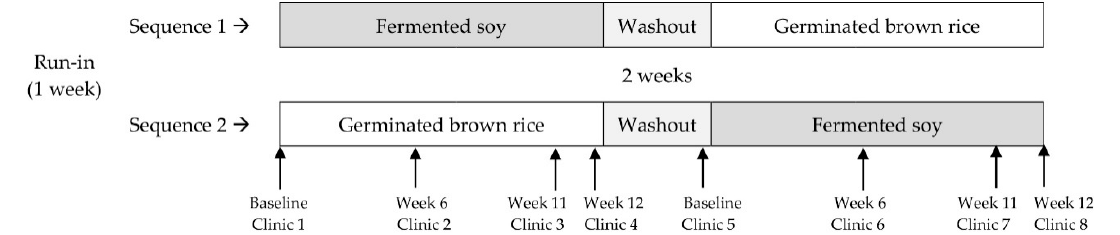
Figure 1. Study design of a randomized, controlled, crossover study in which participants with at least two risk factors for cardiovascular disease (CVD) consumed daily 2 packets of a powdered fermented soy product Q-Can Natural or 2 packets of a powdered germinated rice food, each dissolved in a liquid for a period of 12 weeks each, separated by a 2-week washout period. The packets were taken in a beverage of their choice—either water, low-fat milk or a plant-based milk—but participants had to be consistent in their choice of beverage. Anthropometric and blood pressure measurements and fasted blood were collected on study visits at baseline and weeks 11 and 12. A 24 h urine sample was collected at week 12.